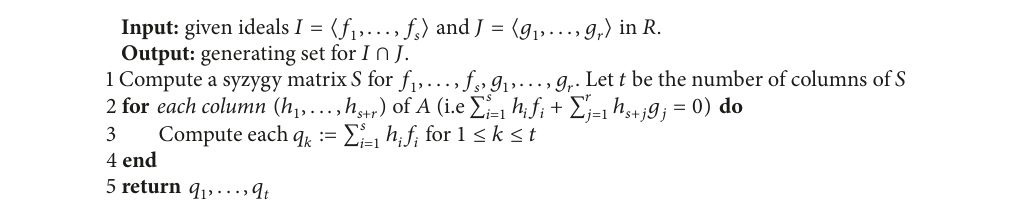
Algorithm 5: Computing a generating set for 𝐼 ∩ 𝐽